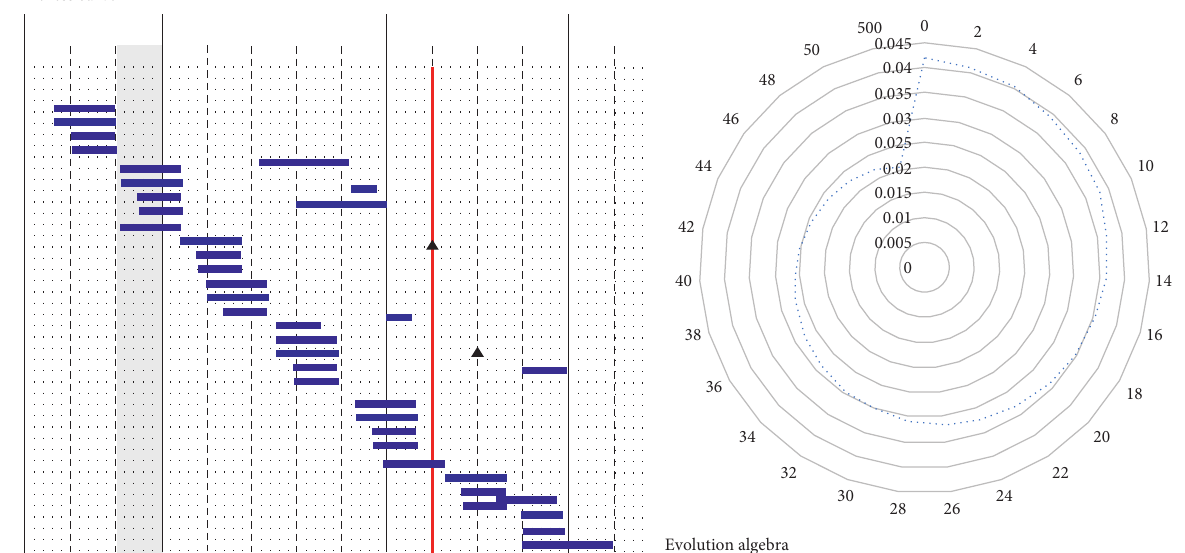
Figure 10: Genetic algorithm convergence result stability evaluation of rock